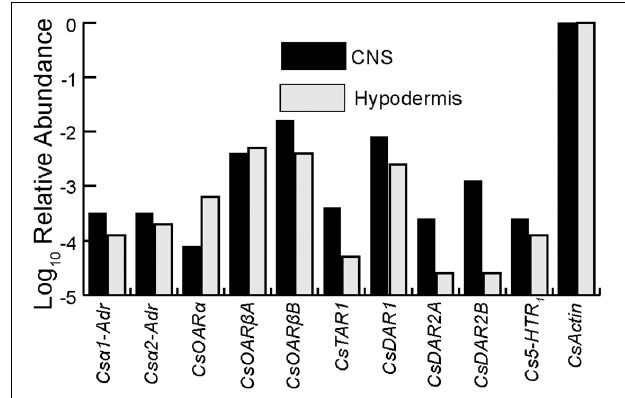
FIGURE 1 | Relative abundances of biogenic amine receptors in the C. salei CNS and hypodermis transcriptomes. The data were obtained by counting total reads in the transcriptome libraries with at least 90 consecutive identical nucleotides to the reading frame of each gene, then normalizing by reading frame length. Abundances in CNS are indicated in black while the hypodermis is indicated in light gray. The scale is logarithmic. Accession numbers and sequence nomenclature are shown in Table 1